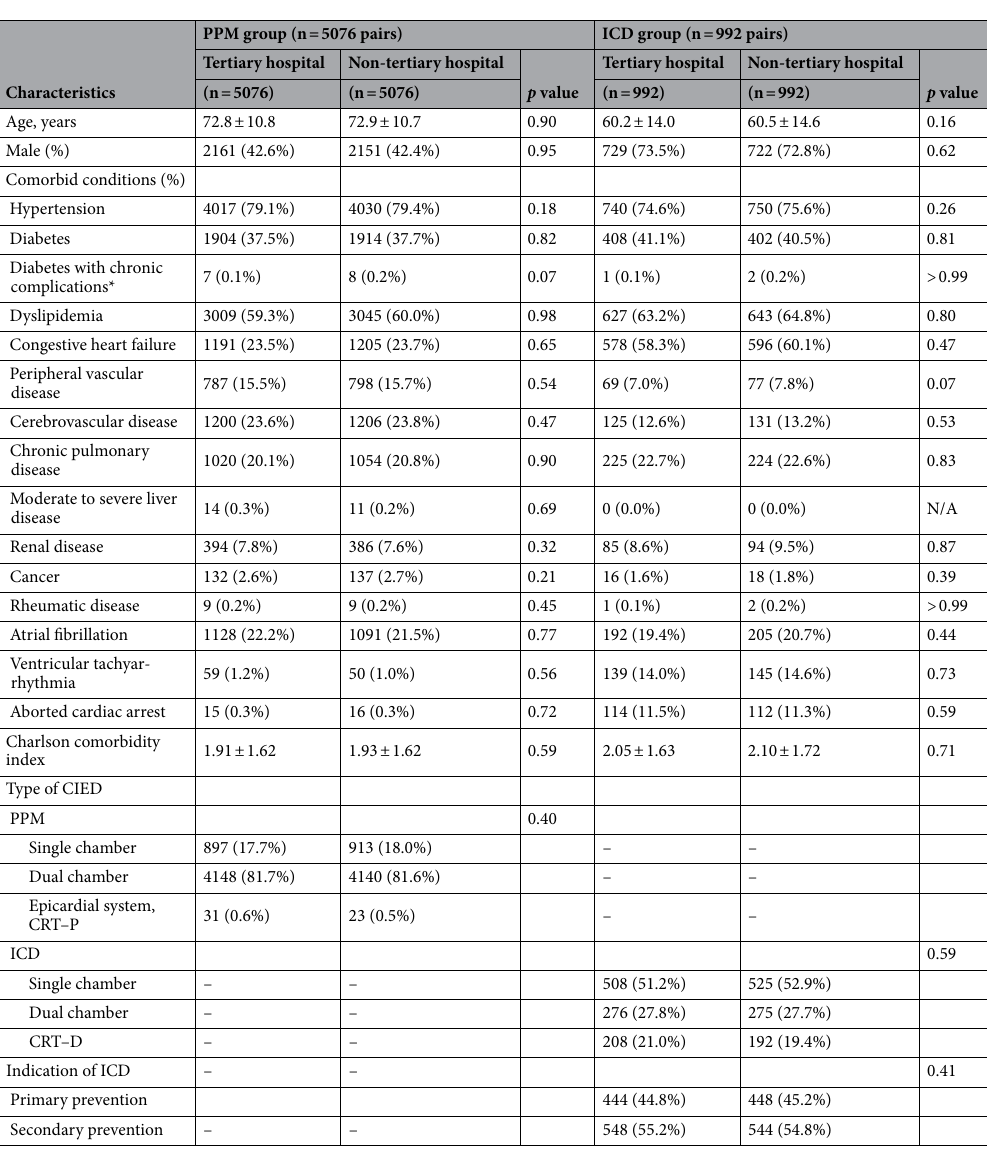
Table 2. Baseline characteristics of the propensity-score matched patients undergoing new implantation of cardiac implantable electronic device in tertiary and non-tertiary hospital. Data are reported as mean ± SD or as number (%). CIED, cardiac implantable electronic device; CRT–D, cardiac resynchronization therapy with defibrillator; CRT–P, cardiac resynchronization therapy with pacemaker; ICD, implantable cardioverter- defibrillator; PPM, permanent pacemaker. *Including diabetic nephropathy, retinopathy, or neuropathy.